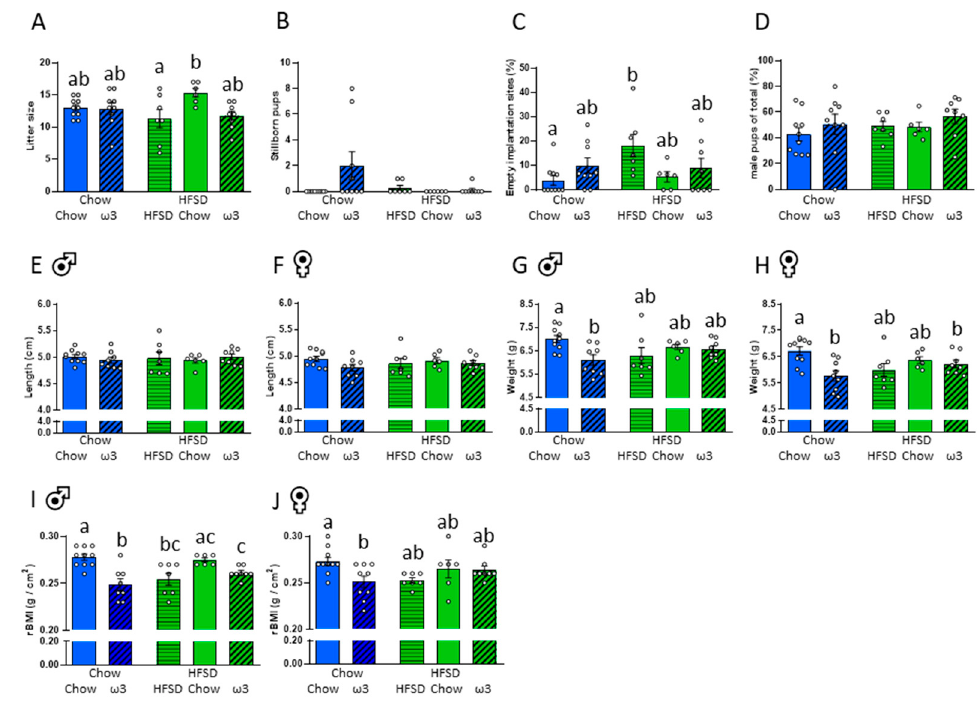
Figure 2. Effects of maternal pre- and post-conception diet on pup survival and morphometric outcomes. ( A ) Total litter size. ( B ) Number of stillborn pups. ( C ) Percentage of implantation sites additional to the number of pups born. ( D ) Sex ratio (% of male pups). ( E ) Pup length, males. ( F ) Pup length, females. ( G ) Pup weight, males. ( H ) Pup weight females. ( I ) Rat body mass index (rBMI), males. ( J ) rBMI, females. HFSD: high-fat-high-sugar diet. Letters denote post hoc differences between groups ( p < 0.05). Data are mean ± SEM ( n = 6–10). Panels A–D: Each data point represents the mean of one litter. Panels E–J: Each data point represents the mean of one litter per